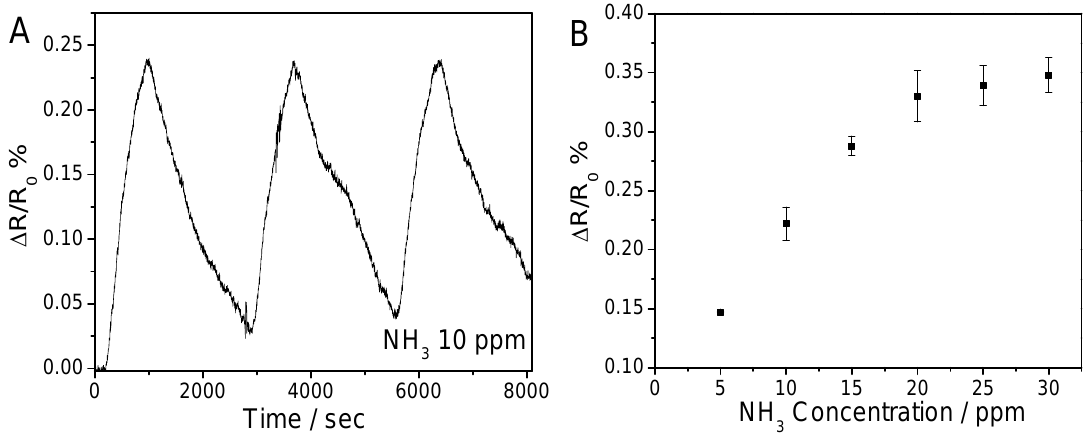
. (B) The calibration plot for NH 3